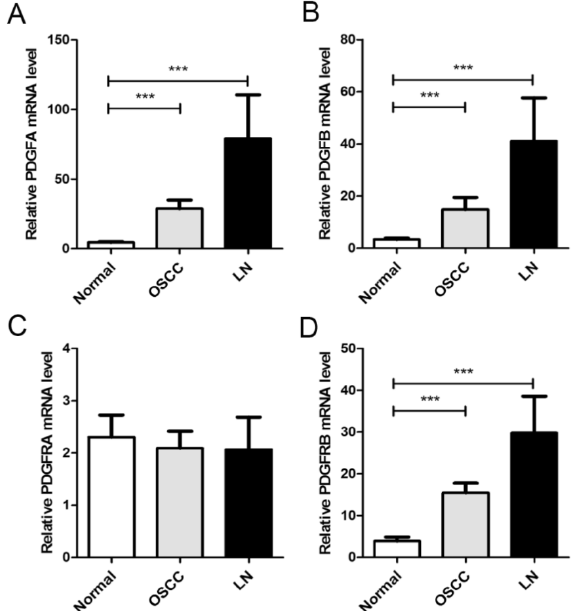
Figure 1. mRNA expression profiles of matched non-cancerous oral mucosa, cancer, and lymph node metastatic tissues. Histograms showing the mRNA levels of PDGFA ( A ), PDGFB ( B ), PDGFRA ( C ), and PDGFRB ( D ) in matched non-cancerous oral mucosa, cancer, and lymph node metastatic tissues. The relative mRNA expression levels were calculated using the 2 −ΔΔ Ct method. ***, p < 0.001